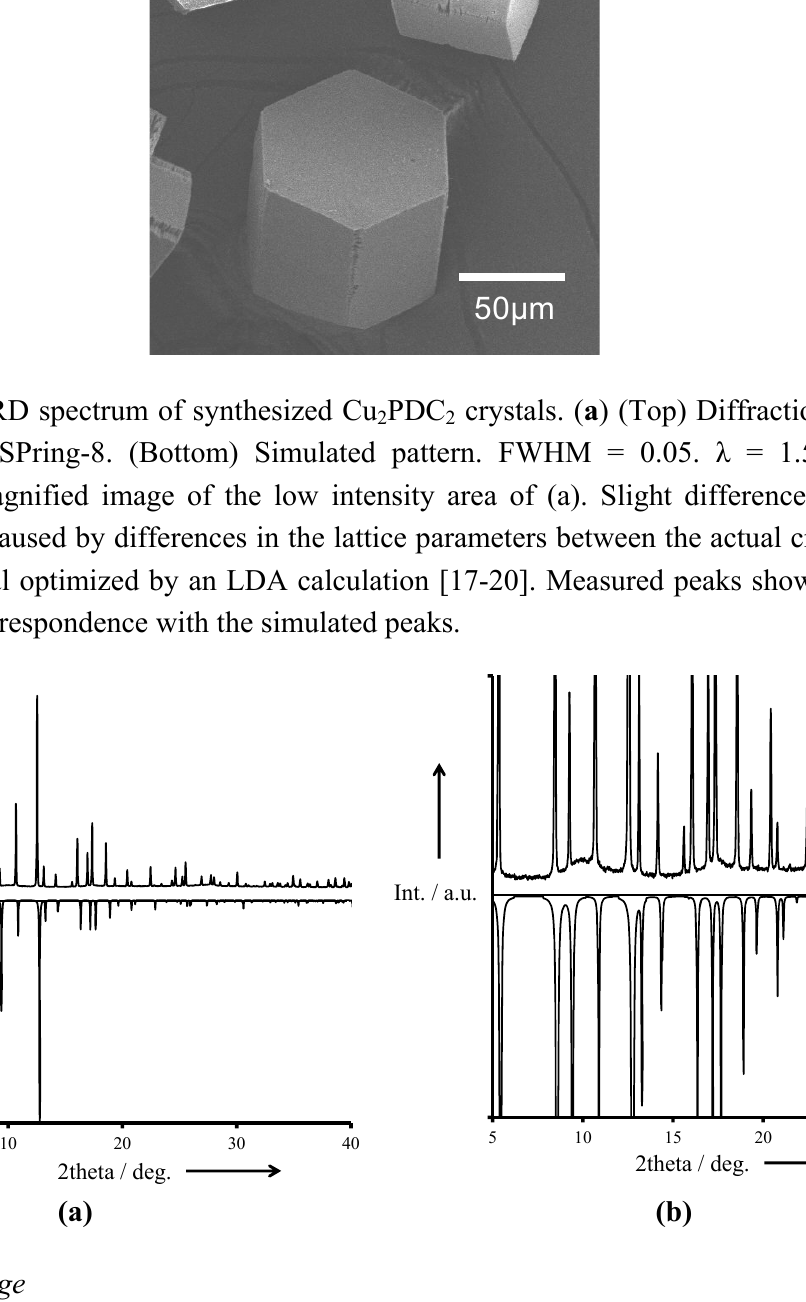
Figure 2. SEM image of the synthesized Cu